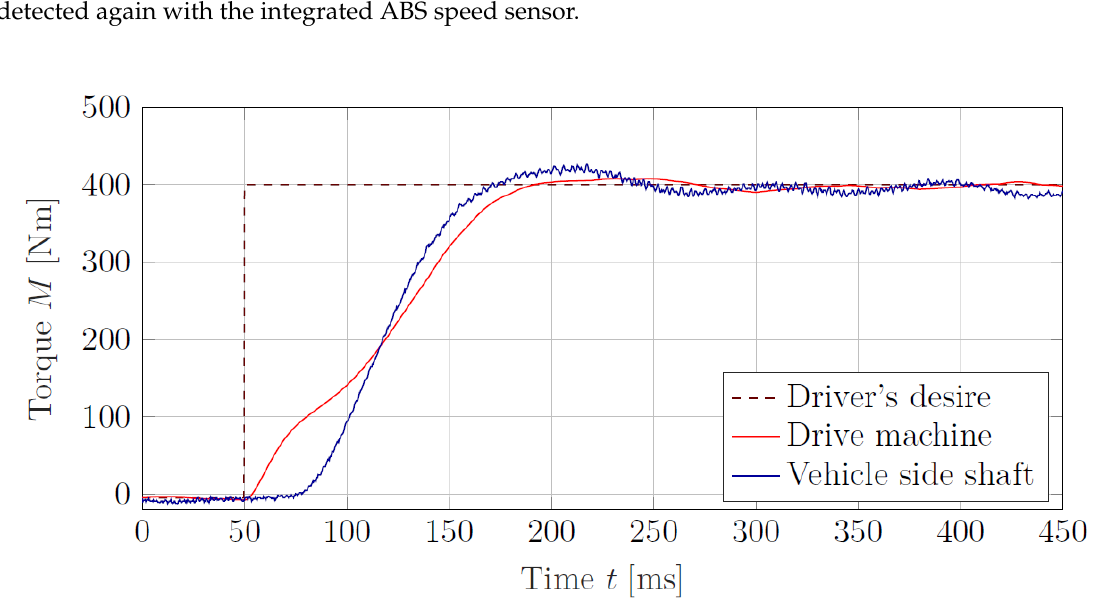
Figure 15. Torque curves as a result of the setpoint step in the driver′s desired torque with prefilter and active anti-jerk control while driving off.